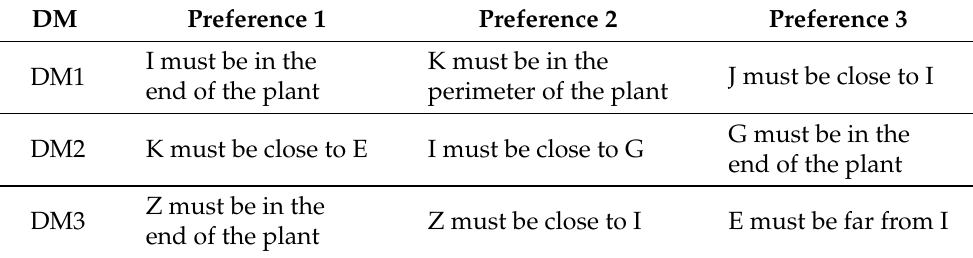
Figure 6. Material flow requirements for the ChoppedPlastic problem. Table 7. DMs’ particular preferences for ChoppedPlastic